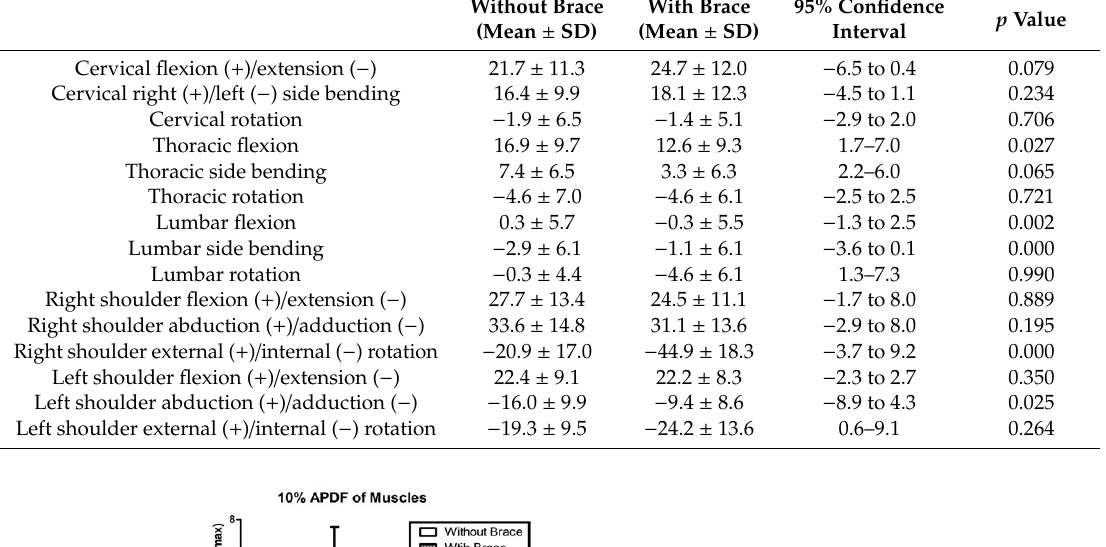
Without Brace With Brace 95% Confidence Without Brace (Mean ± SD) (Mean ± SD)